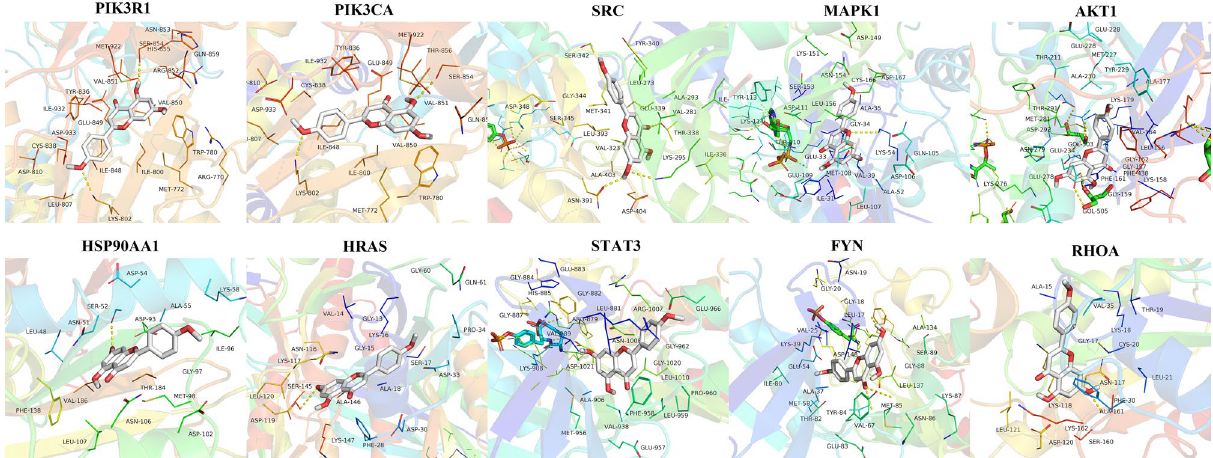
Figure 8. Schematic diagram of docking results. The docking results of acacetin with 10 core target proteins are